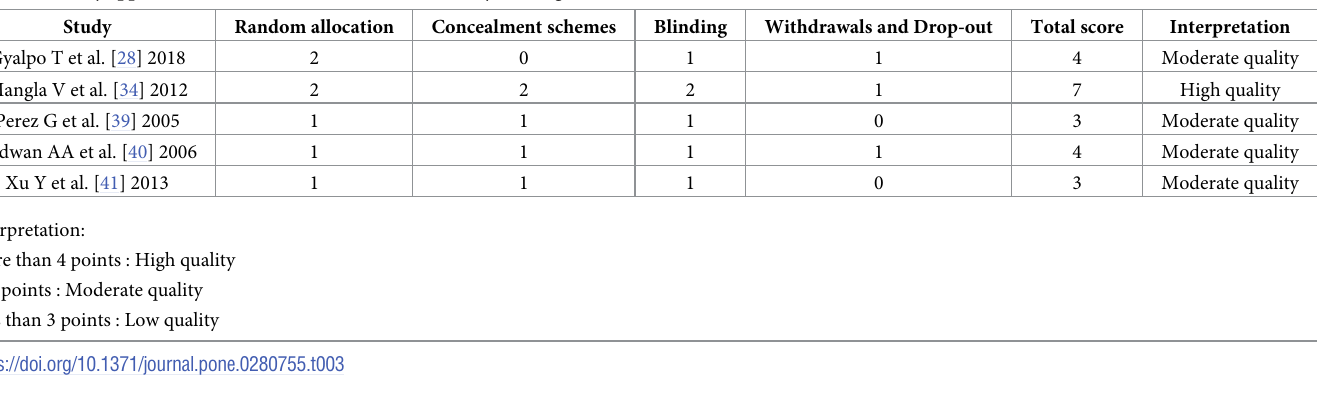
Table 3. Quality appraisal of studies included in the meta-analysis using the Jadad scale